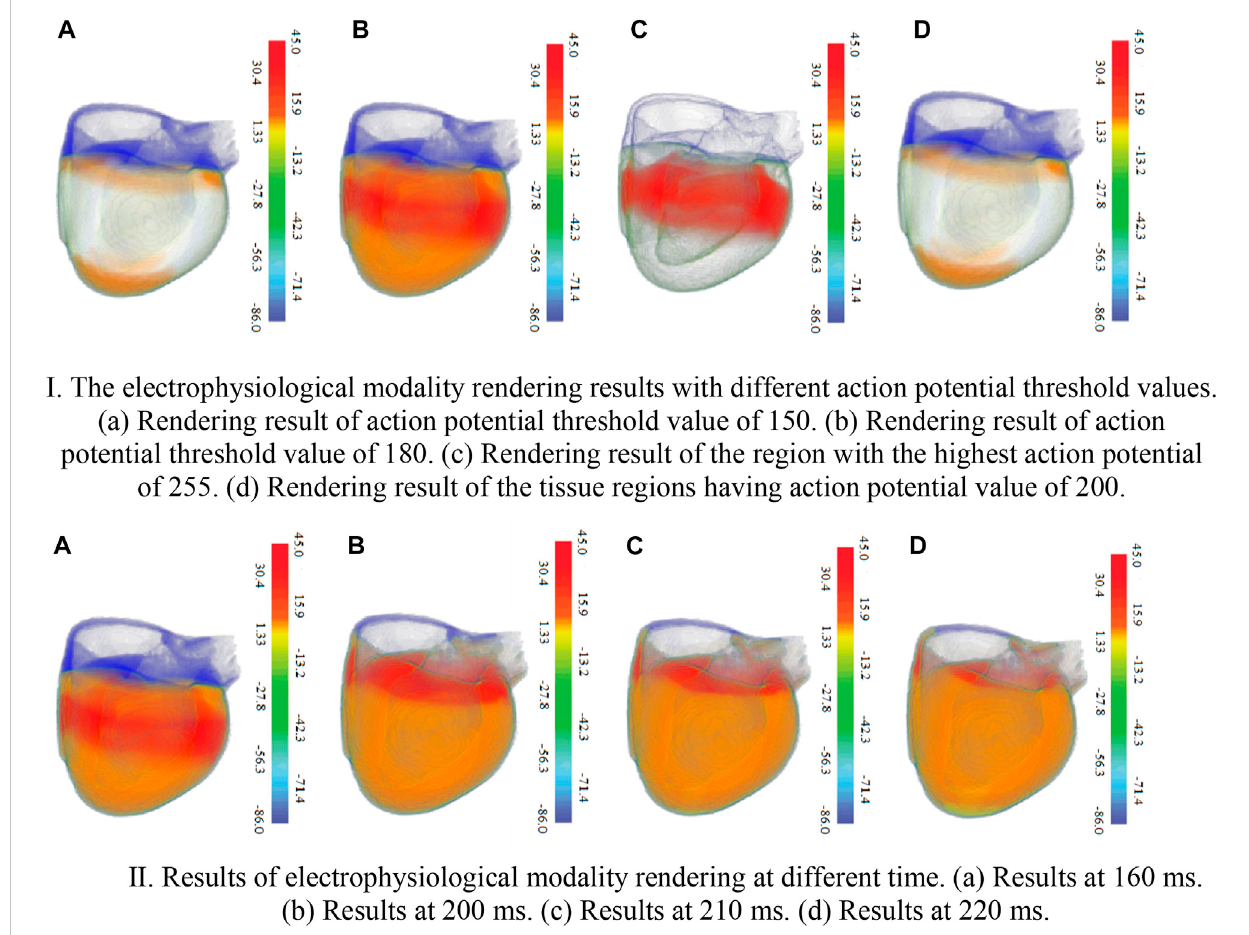
FIGURE 8 The electrophysiological modality rendering results. Ⅰ . The electrophysiological modality rendering results with different action potential threshold values. 426 (a). Rendering result of action potential threshold value of 150 (b). Rendering result of action 427 potential threshold value of 180 (c). Rendering result of the region with thehighestaction potential 428 of255 (d). Rendering result of thetissue regions having action potential value of200. Ⅱ . Results of electrophysiological modality rendering at different time (a). Results at 160 ms. 432 (b) Results at 200 ms. (c) Results at 210 ms. (d) Results at 220